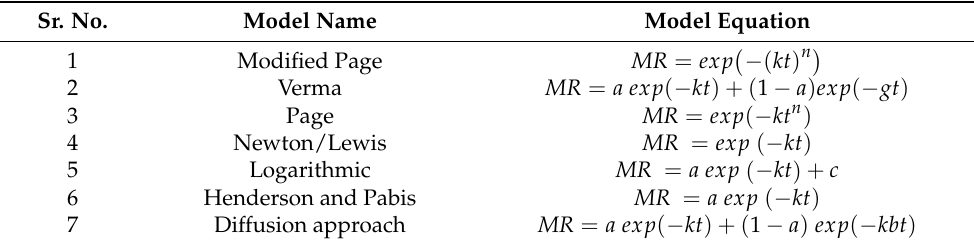
Table 1. Selected semi-empirical models used for the plantain banana drying kinetics [10]. Sr. No. Model